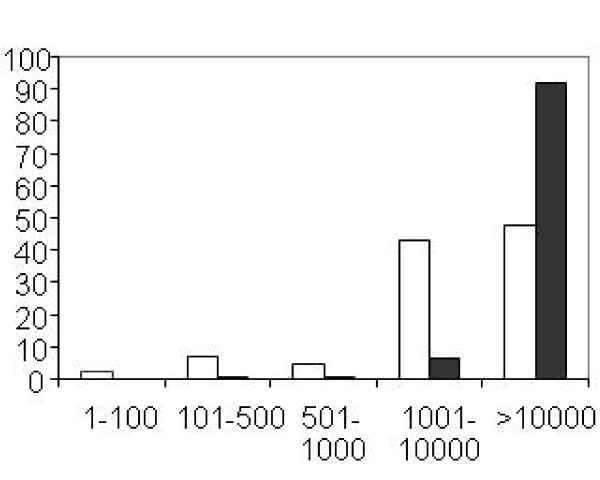
Frequency of sequence reads among the pea aphid miRNAs. Those miRNAs that are also found in other species show higher read frequencies than the pea aphid specific miRNAs. For the two batches of miRNAs (in black, miRNAs found in other species and in white miRNAs found only in A. pisum), the number of reads have been distributed between 5 classes: miRNAs represented by 1-100 reads, 101-500 reads, 501-1000 reads, 1001-10000 reads or >10000 reads. The figure shows for each batch the percentage of miRNAs in each class.